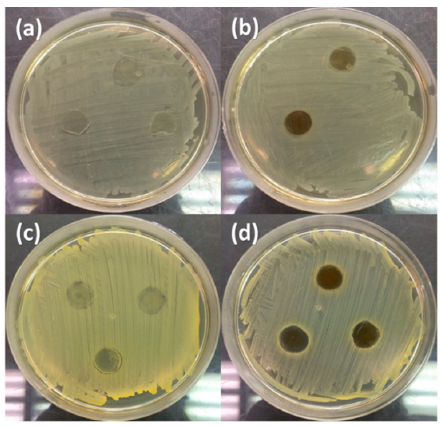
Figure 7. Photographs of the inhibition zones of PVP/CNC against E. coli ( a ) and S. aureus ( c ); and PVP/CNC-4%/AgNO 3 -0.34% against E. coli ( b ), and S. aureus ( d ).